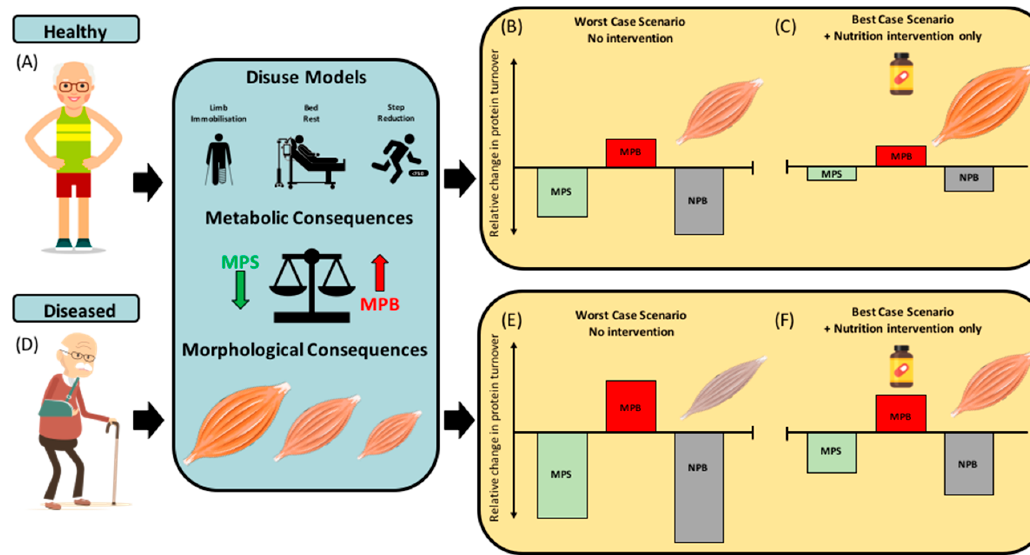
Figure 2. Illustration of the e ff ects of disuse events on mechanisms of disuse atrophy in older healthy and diseased phenotypes and theoretical potential for nutritional interventions to mitigate these detrimental e ff ects. ( A – C ) The e ff ects of disuse (bed-rest and unilateral limb immobilisation) and inactivity (step reduction) on muscle protein synthesis (MPS), breakdown (MPB), net protein balance (NPB) and muscle mass in healthy older adults, with the worst-case scenario (i.e., disuse with no nutritional strategy) and best-case scenario (i.e., with potentially e ff ective nutritional strategy). ( D – F ) The e ff ects of disuse and inactivity on MPS, MPB, NPB and muscle mass in older adults with compromised health status (frailty, malnutrition syndrome, cachexia and chronic inflammatory disease) and the worst- and best-case scenario. With nutritional intervention-only, the best-case scenario may result in more positive NPB (albeit still negative) and an attenuated rate of muscle atrophy. NB: The improvement in NPB outlined in the best-case scenario panels is driven primarily through nutritional stimulation of MPS, whereas nutrient-induced MPB suppression plays a lesser role (due to the absence of clear evidence demonstrating MPB suppression with nutritional interventions during disuse).